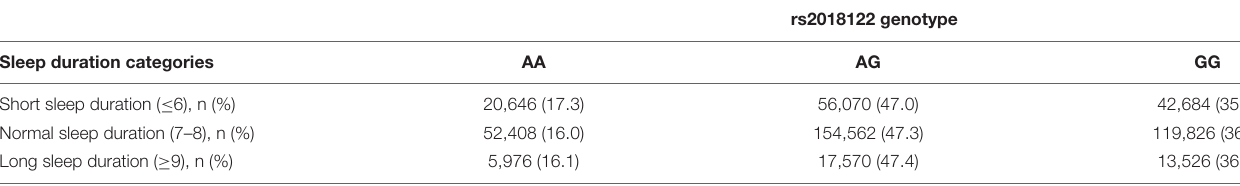
TABLE 2 | Crosstab between sleep duration categories and RORA rs2028122 genotype.